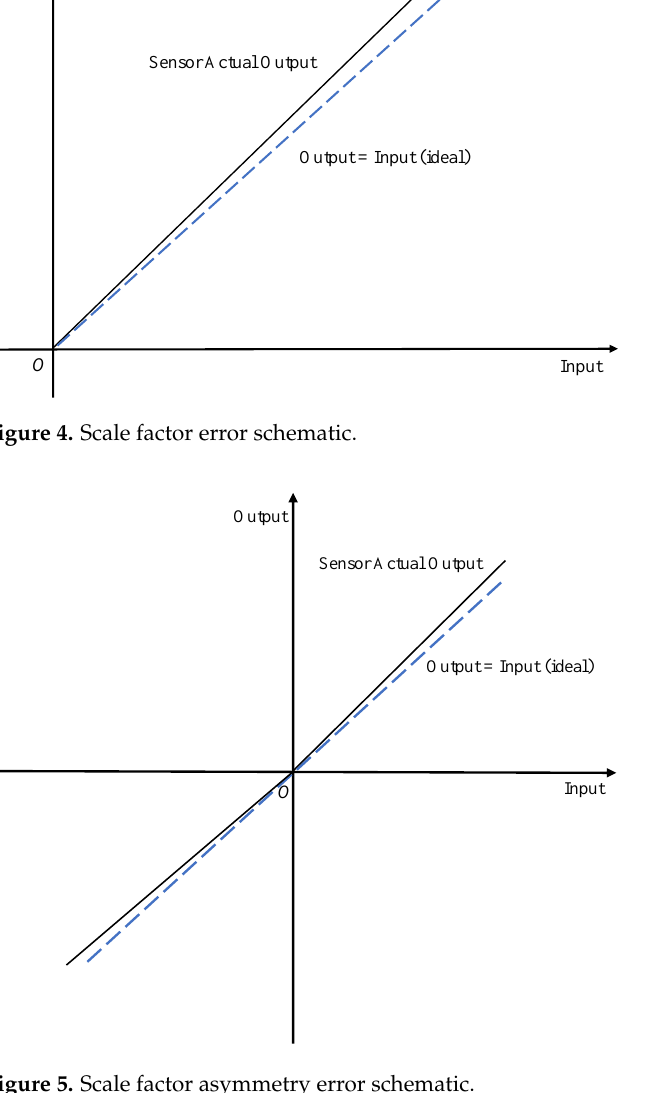
Figure 5. Scale factor asymmetry error